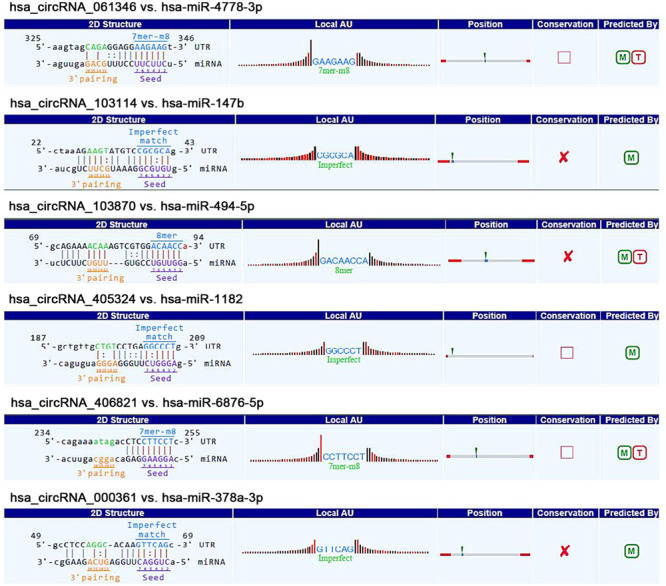
The detailed potential circRNA–miRNA interaction sites of targeted miRNAs with highest context score percentile based on TargetScan and miRanda data.